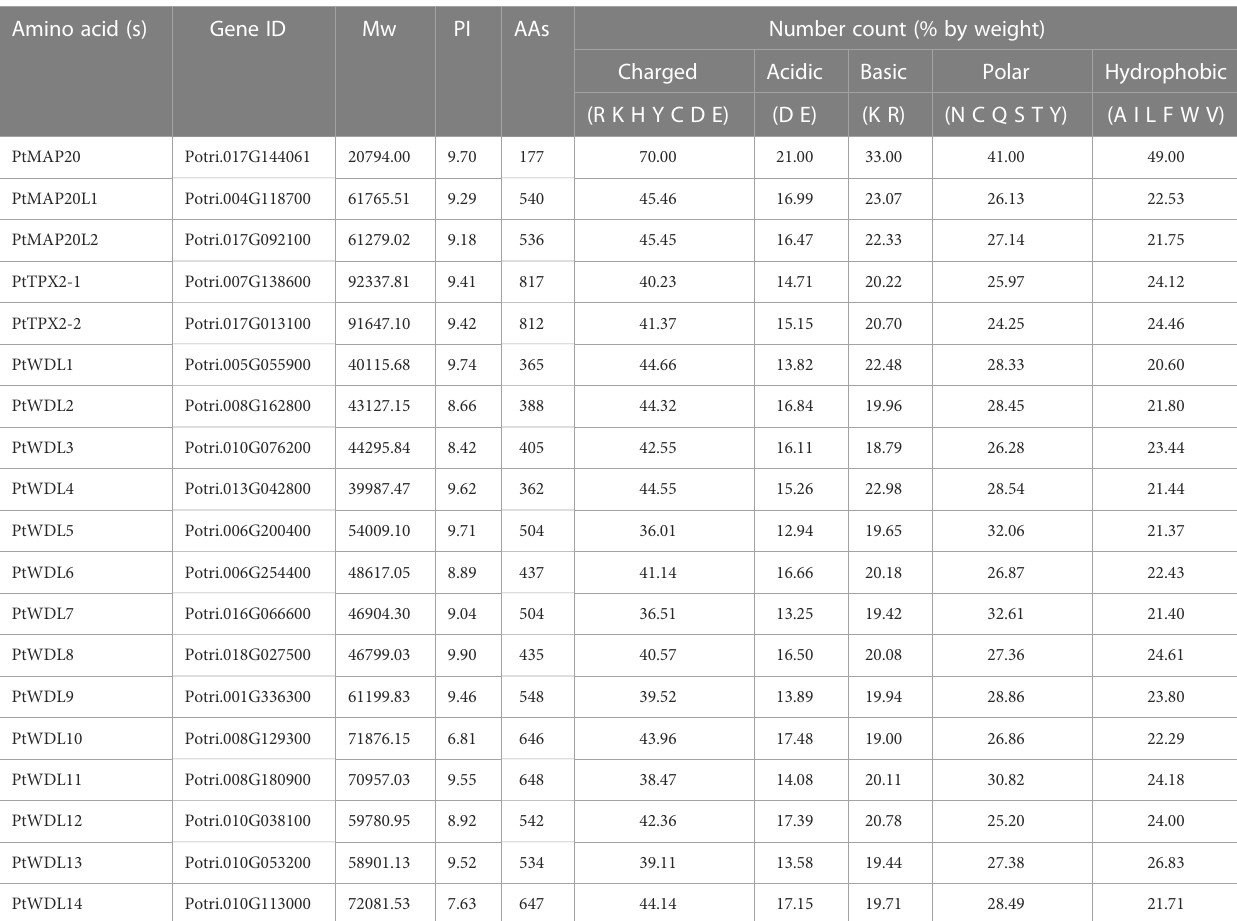
TABLE 1 Information of PtTPX2 protein structures and amino acid